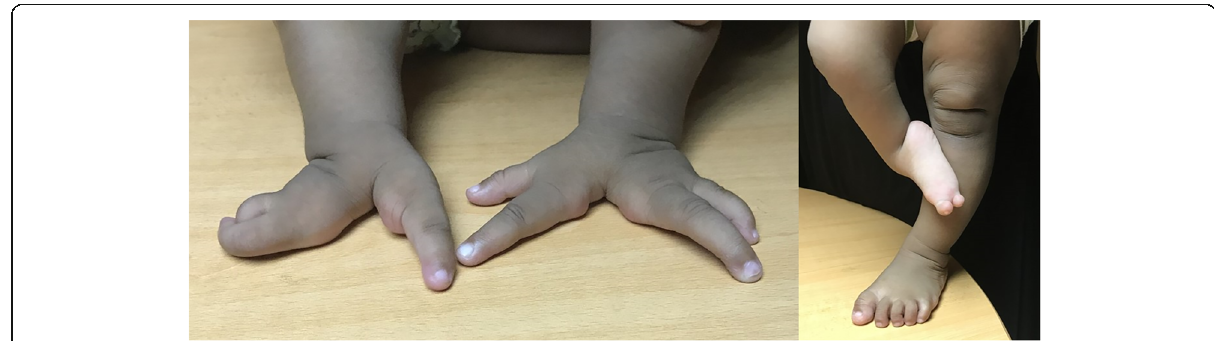
Fig. 1 Clinical photographs of the hands and the feet of the proband showing ectrodactyly involving three limbs, with the absence of the third digit on the left hand, absence of 2 digits on the right hand with malformed fingers (except the thumb) and the fixed clubfoot deformity with only 2 toes on the right